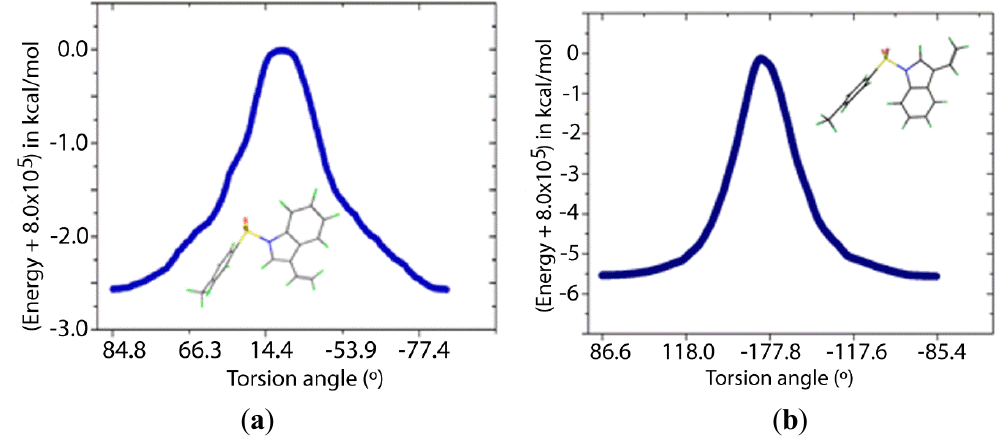
Figure 9. IRC of the rotational barrier about the S-N bond in 2 : ( a ) 2TS1 and ( b ) 2TS2 . Insets are the corresponding molecular